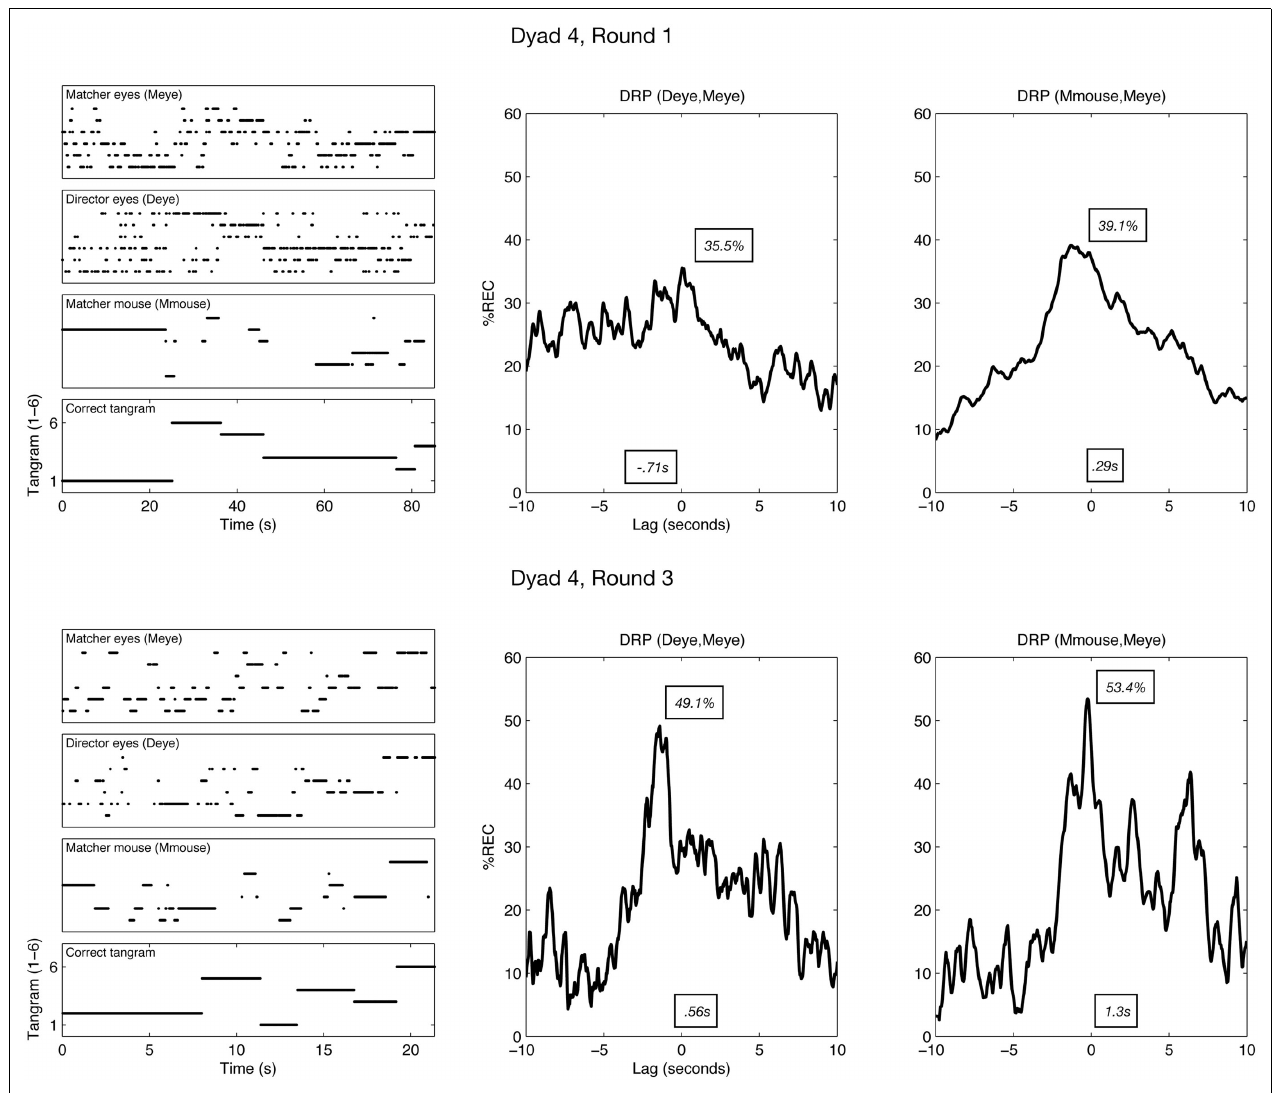
these time series, with mean (s) and maximum (%) shown as examples of quantifying the profiles as a distribution (DRP = diagonal-wise recurrence profile).The profile is constructed by finding how much each time series matches (expressed as percentage recurrence, %REC) when they are lagged relative to one another.The maximum would reflect, for example, the relative point in time at which the channels are maximally aligned. See main text for more